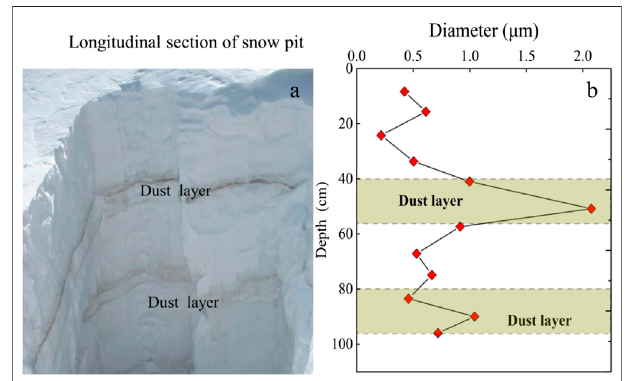
FIGURE 5 | Image of snow pit (A) and variation in dust diameter with depth (B) .